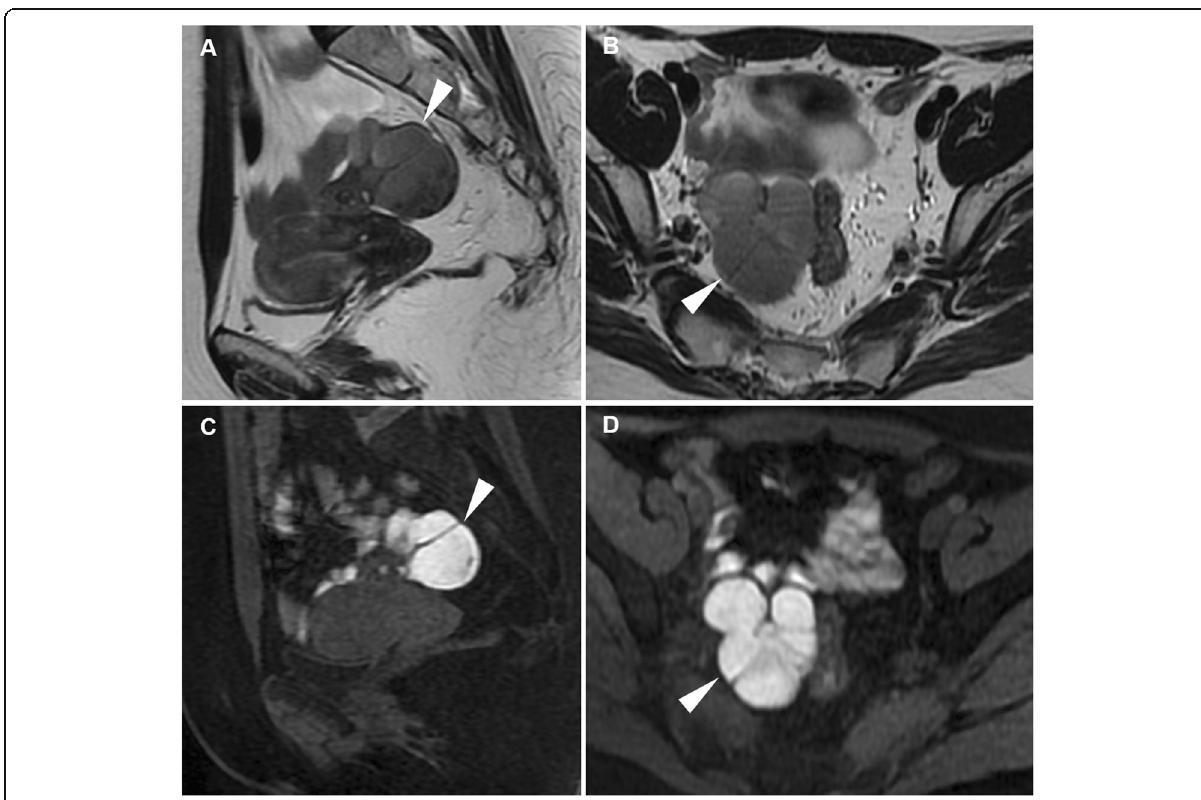
Fig. 18 Haematosalpinx in a 34-year-old woman with endometriosis presenting with dysmenorrhea and pelvic pain. Sagittal ( a ) and oblique- coronal ( b ) T2-weighted images show a tortuous structure with homogeneously hypointense content in right adnexa (arrowheads). On sagittal ( c ) and oblique-coronal ( d ) fat-suppressed T1-weighted images the same structure (arrowheads) shows high signal intensity consistent with